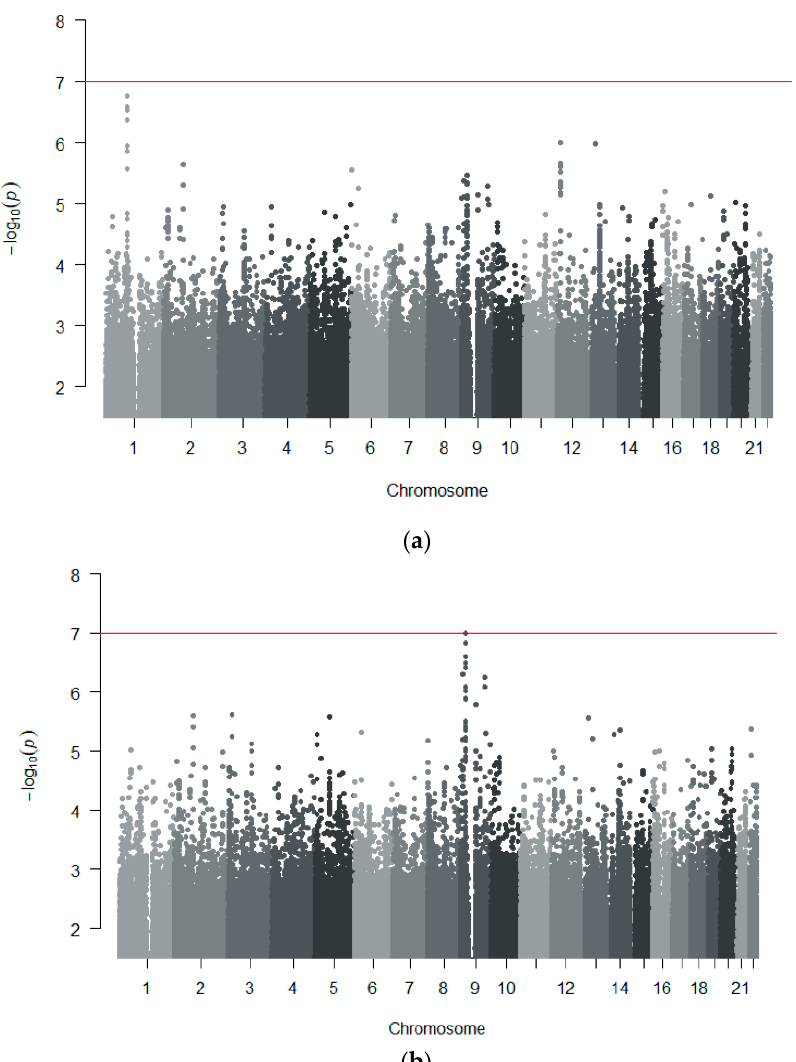
Figure 3. Manhattan plot of GWAS meta-analyses in the three independent cohorts ( MIA / MIN-CH, EuDAC-ES and EuDAC-DE ) . Results from approximately 7 million SNPs after imputation and quality control are shown, adjusted by multidimensional scaling (MDS) dimensions 1–4 and sex (only for EuDAC-ES). The red line shows the threshold for genome-wide significance of 1 × 10 − 7 . ( a ) Analysis of all 86 cases (MIA and MIN) versus 464 controls (tolerant and unexposed). The top SNP was rs11583606, located in an intron of the TGFBR3 gene on chromosome 1. ( b ) Analysis of 71 agranulocytosis cases (MIA) versus 464 controls (tolerant and unexposed). The top SNP was rs55898176, located in an intergenic region nearest to the CAAP1 gene on chromosome 9.